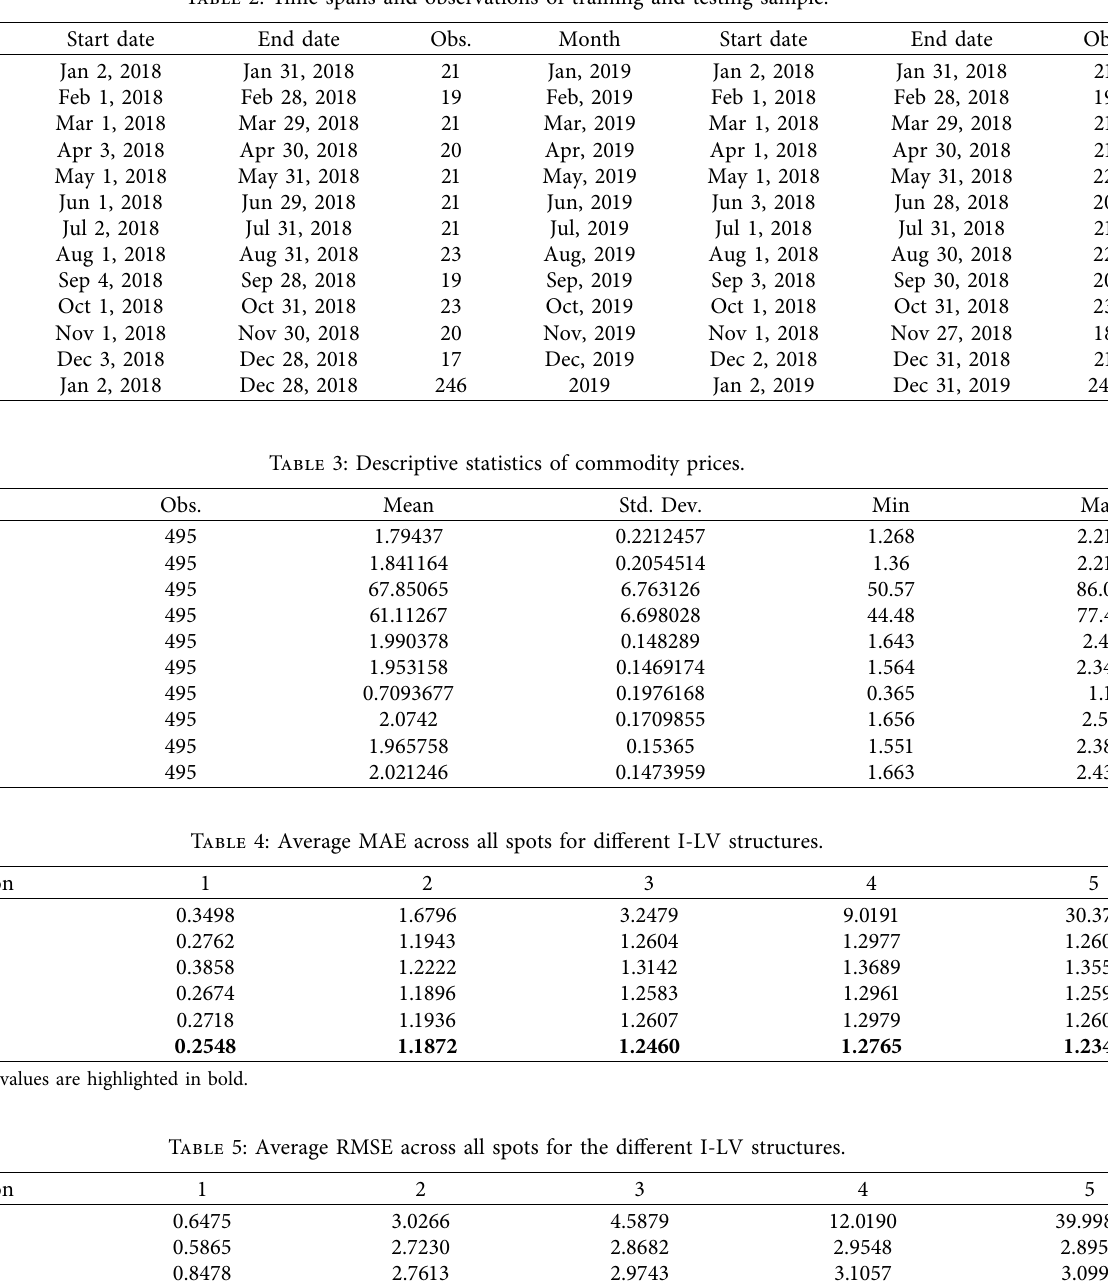
Table 2: Time spans and observations of training and testing sample.